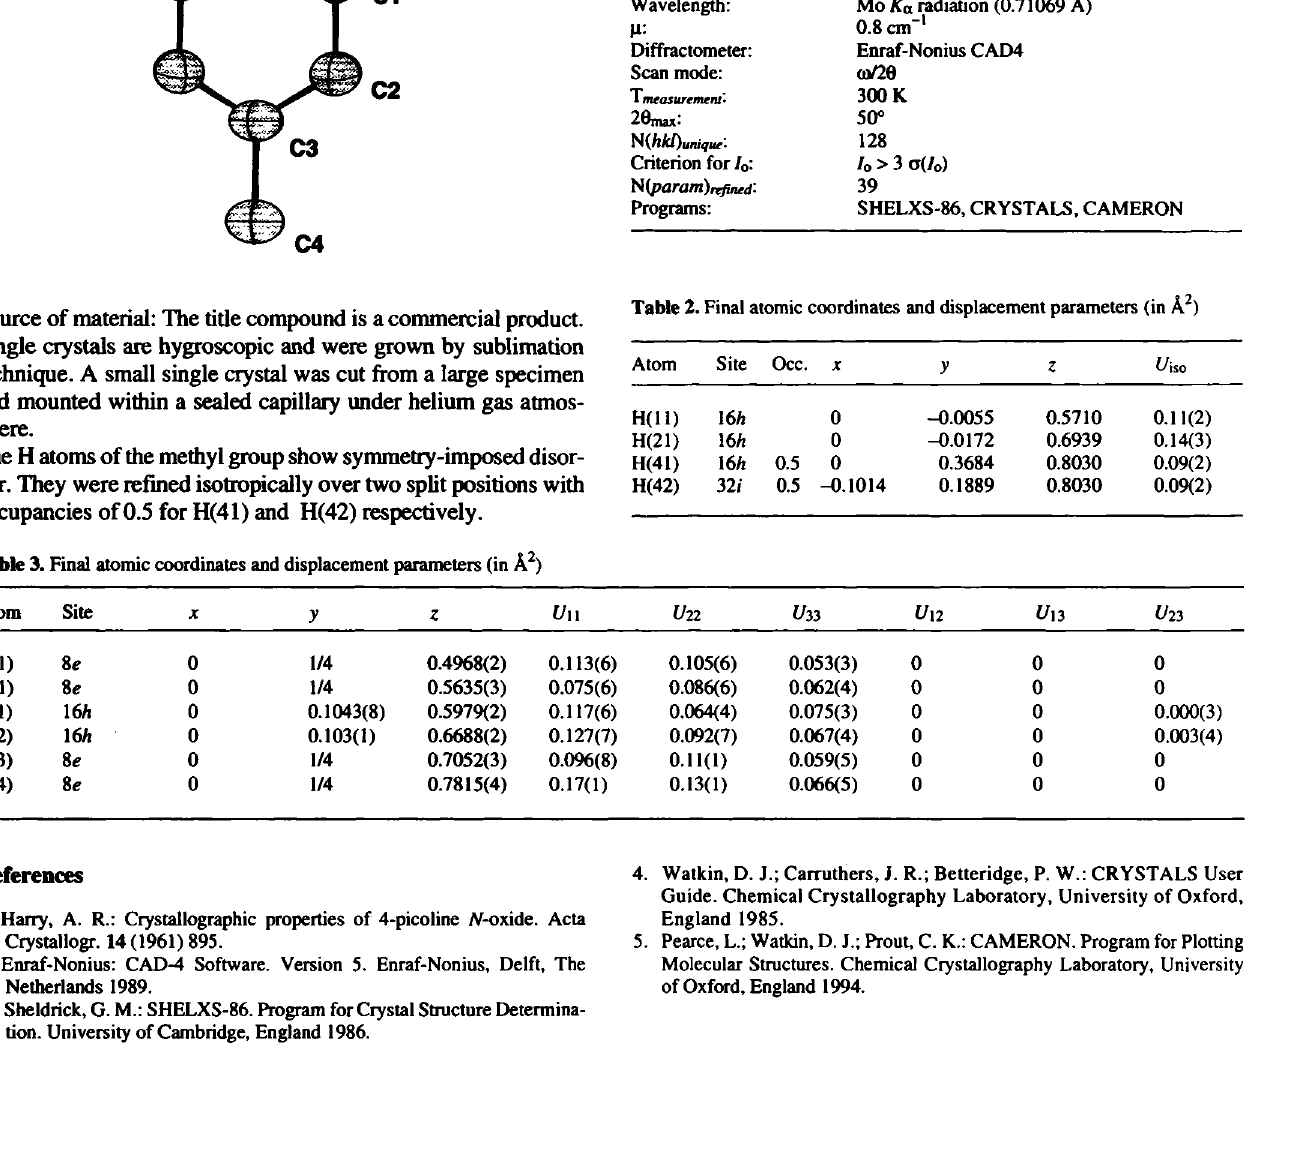
Table 1. Parameters used for the X-ray data collection Crystal: